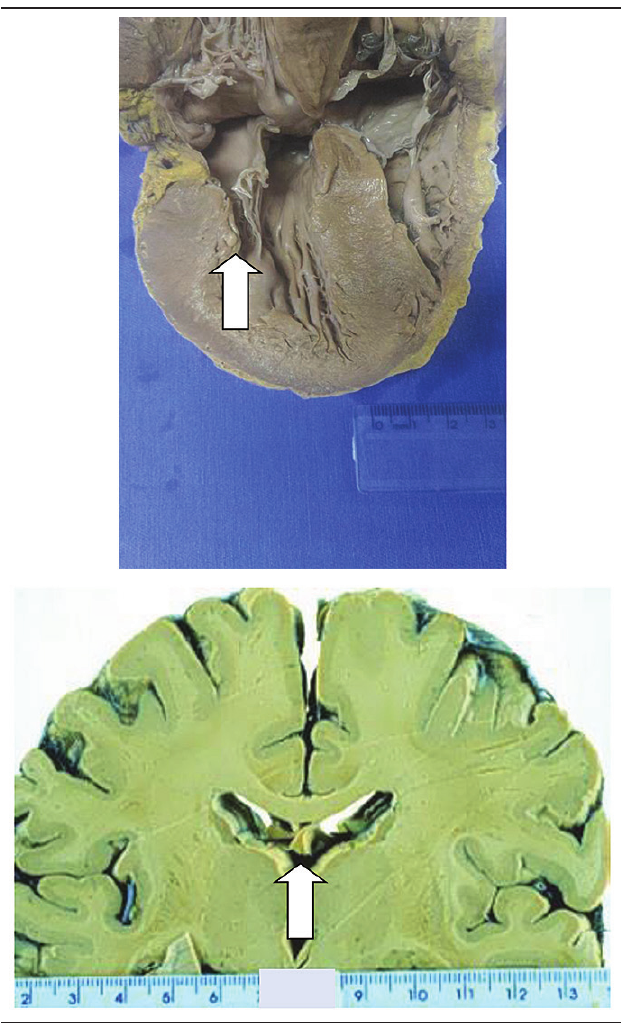
figurE − Macroscopic aspect of brain and heart obtained from autopsied patients with cysticercosis, from 1990 to 2018